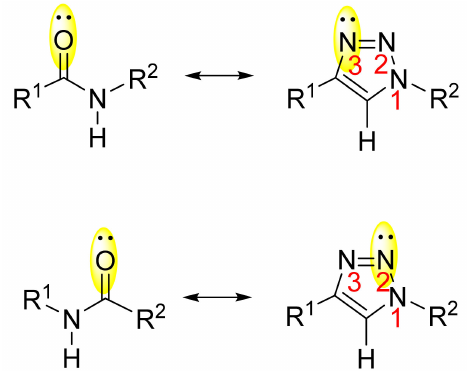
Figure 27. Different ways of mimicking amide